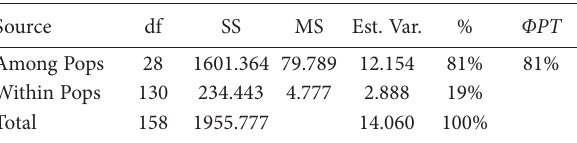
Table 4. Analysis of molecular variance (AMOVA) of the studied